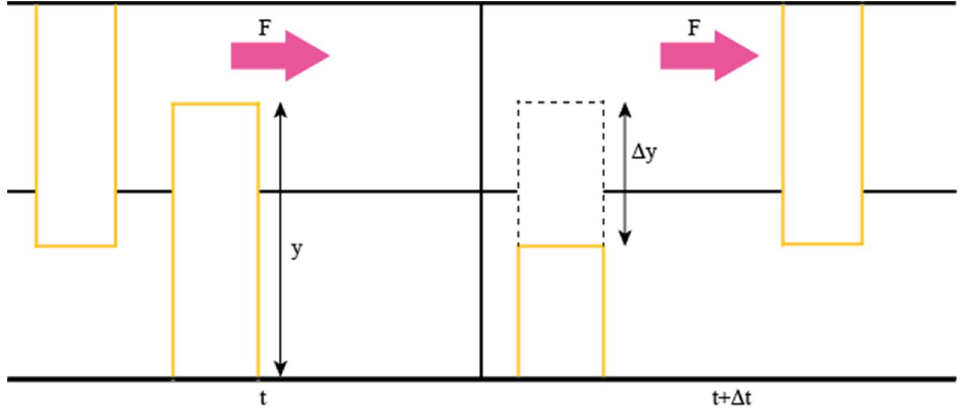
Figure 2. Height changes of an asperity under wear.